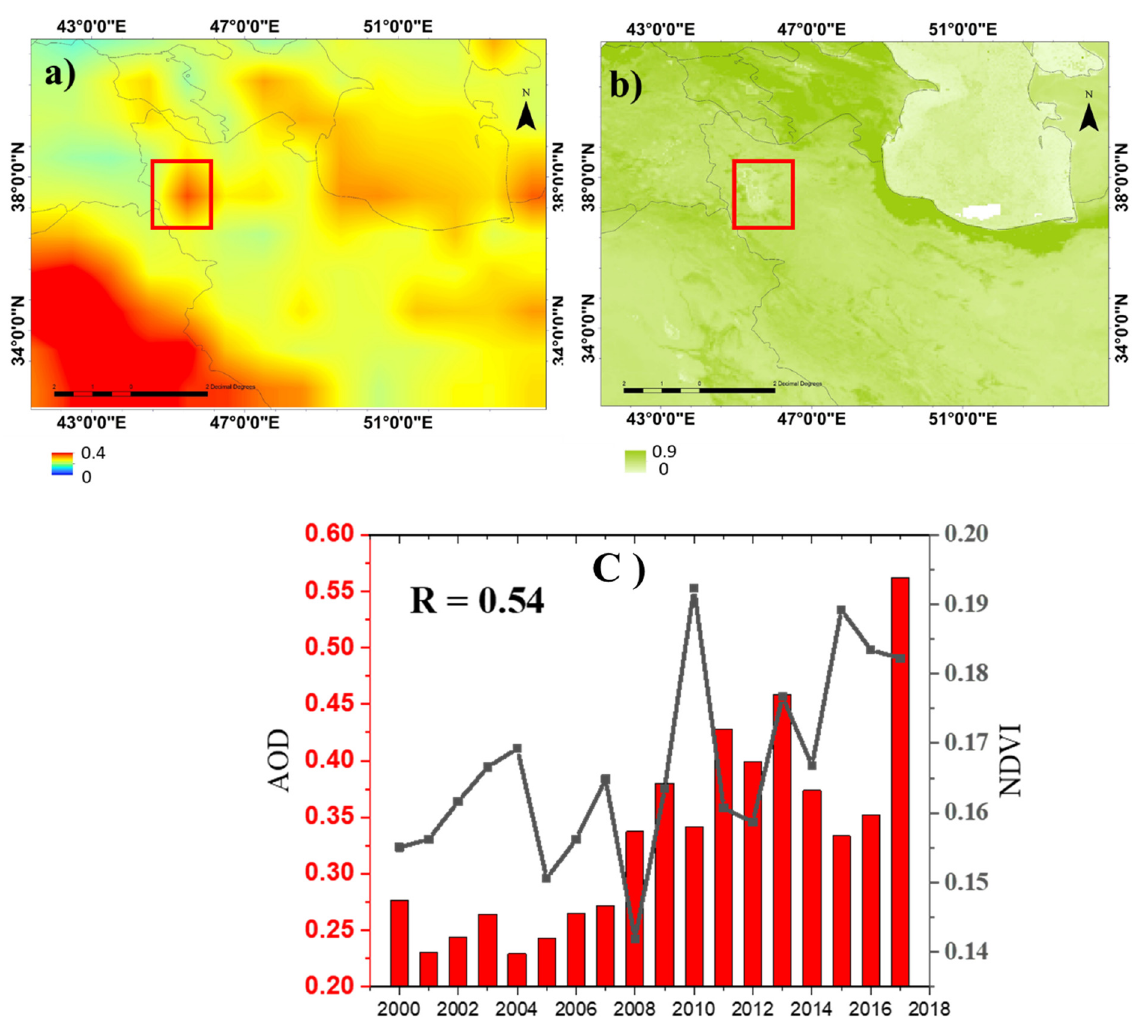
Figure 5. Spatial distribution of MODIS/Terra ( a ) mean AOD 550, ( b ) mean NDVI, and ( c ) Temporal distribution of AOD 550 nm (red bars) and NDVI (black lines) from 2000 to 2017.